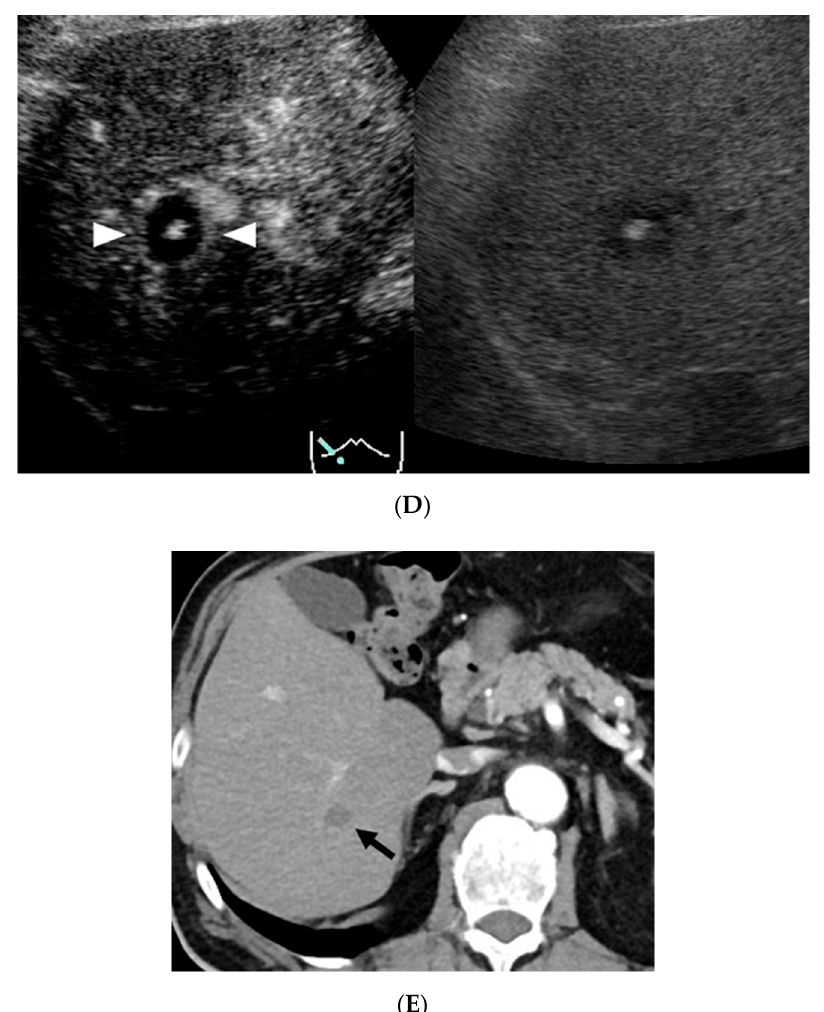
Figure 2. The patient was a 65-year-old male with alcoholic liver cirrhosis. DEB-TACE for HCC in S7 with a diameter of 20 mm and CEUS for the HCC within 3 days after DEB-TACE were performed. ( A ) Contrast-enhanced computed tomography (CECT) in the arterial phase before DEB-TACE showed a hypervascular lesion S7 (arrow). ( B ) CEUS in the vascular phase (40 s) before DEB-TACE showed a hyperenhanced lesion in S7 (arrow) (Right image: Monitor mode). ( C ) Digital subtraction angiography from a branch of A6 before DEB-TACE showed tumor stain (arrow). ( D ) CEUS in the vascular phase (40 s) showed peripheral ring enhancement (Pattern B) in S7 3 days after DEB-TACE (arrowhead). High echoic area in this lesion indicates that micro-air entered with beads during TACE (Right image: Monitor mode). ( E ) CECT in the arterial phase showed hypovascular lesion (complete response) in S7 12 months after DEB-TACE (arrow).